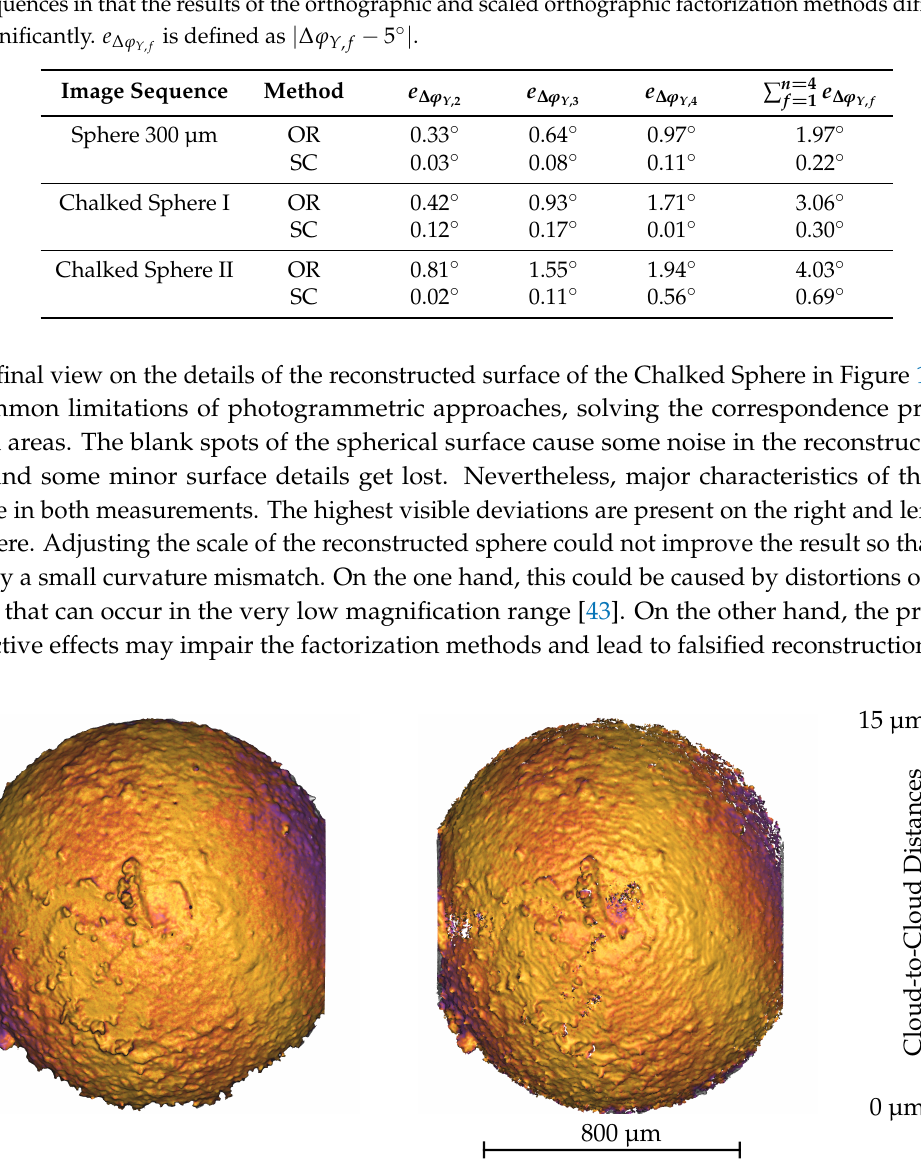
Figure 16. CLSM measurement (left, 2250786 points) and the dense point cloud triangulated with a triangulation angle of ∆ ϕ Y = 5 ◦ (right, 1855408 points) using the scaled orthographic factorization method for the image sequence Chalked Sphere I. Cuts are caused by the measurement field of the CLSM